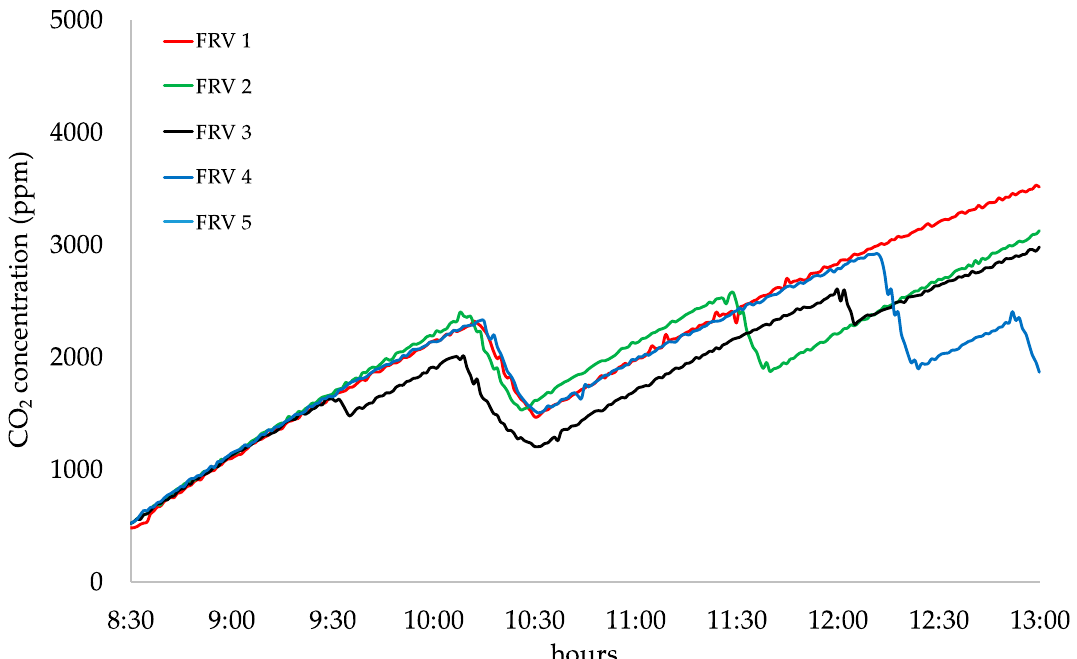
Figure 3. CO 2 trends measured during the free-running ventilation tests (crowding index of about 2.2 m 2 person − 1 ).